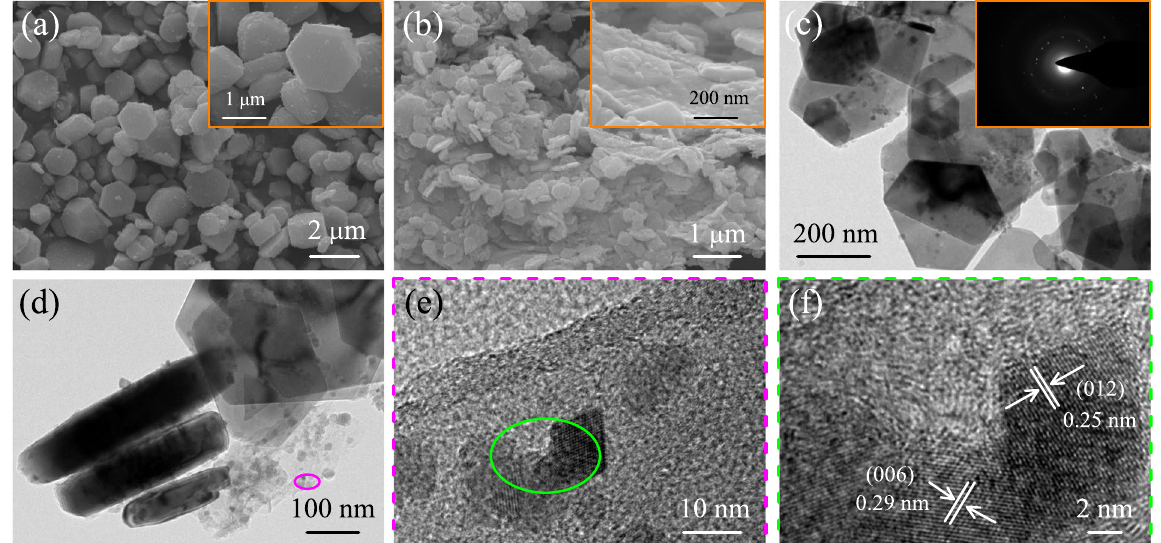
Figure 3. ( a ) SEM image of CuFeO 2 , inset shows the higher magnification. ( b ) SEM image of CuFeO 2 @rGO, inset shows the higher magnification. ( c , d ) TEM images of CuFeO 2 @rGO, inset of ( c ) shows the selected area electron diffraction (SAED) pattern. ( e ) High magnitude TEM image of CuFeO 2 @rGO. ( f ) HRTEM image of